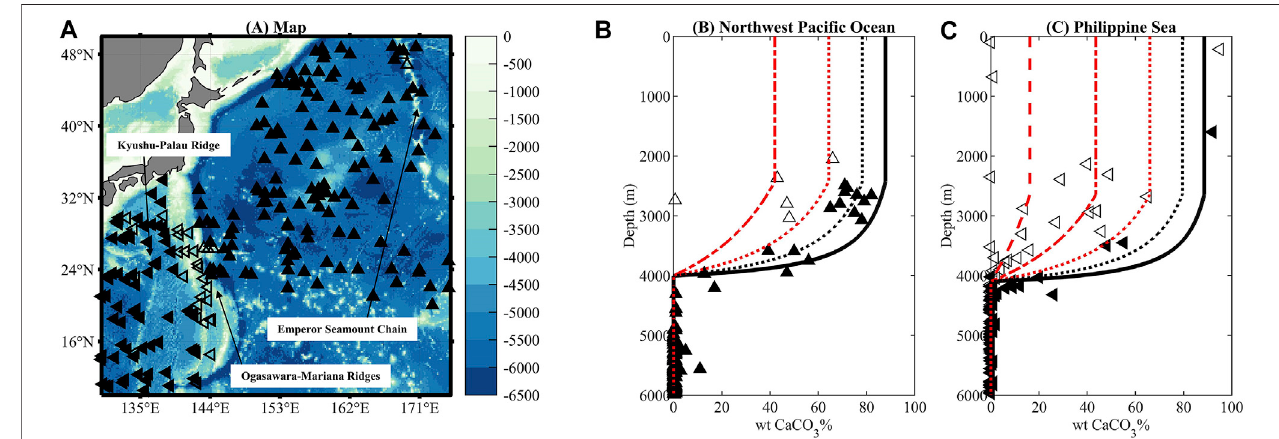
FIGURE4| Map (A) detailingridgesintheWestPaci fi cOceanand (B) plotsofsedimentary wt CaCO 3 %versusdepthinthePhilippineSeaandtheNorthwestPaci fi c Ocean.PelagicsedimentswithhighCaCO 3 contentpresumablynotstronglyaffectedbynon-carbonatedilutionaremarkedby fi lledblacksymbols,whilethosewithlow CaCO 3 contentfromtheEmperorSeamountChain,theOgasawara – MarianaRidge,andKyushu – PalauRidgearemarkedbyun fi lledblacksymbols.Thesolidblacklines are model outputs (control runs) for the pelagic Northwest Paci fi c Ocean (B) and Philippine Sea (C) . The black dotted, red dotted, dot and dash, and dashed lines show sensitivity tests with 2, 4, 10, and 40 times of F M , respectively.